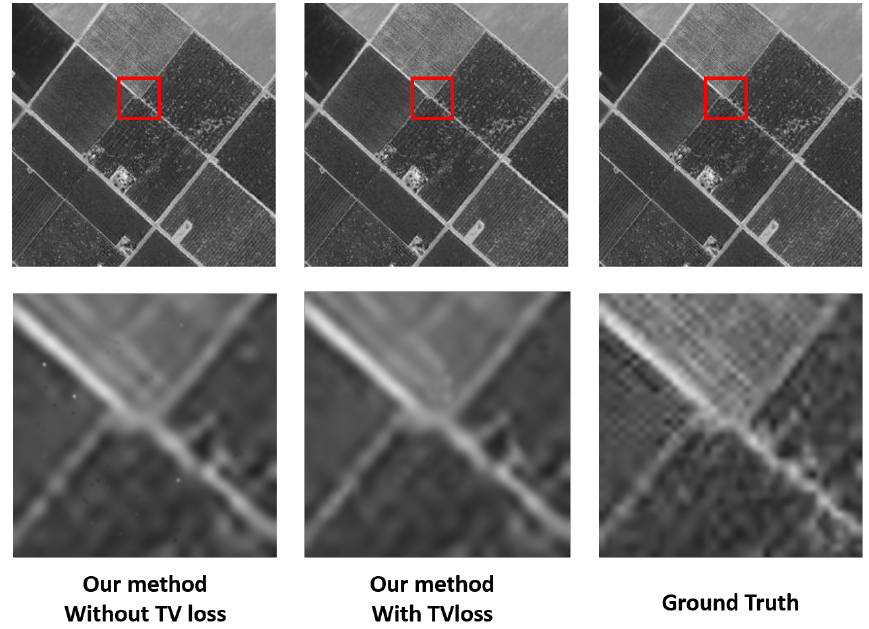
Figure 19. Comparison results of whether using TV loss or